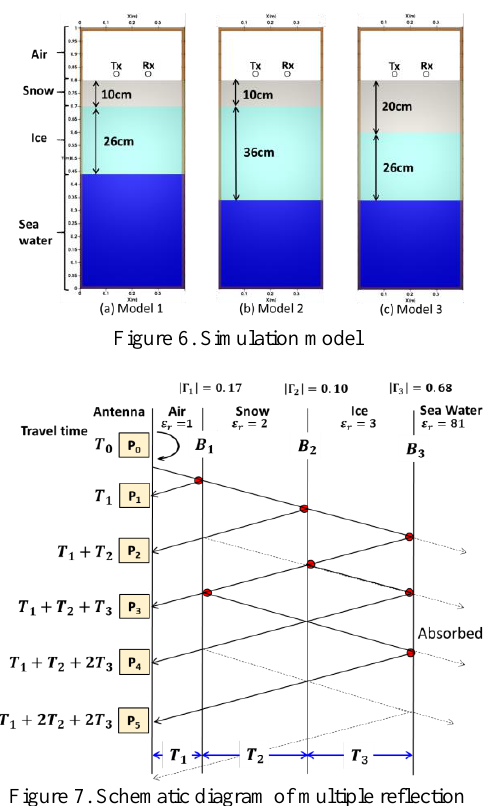
Figure 7. Schematic diagram of multiple reflection